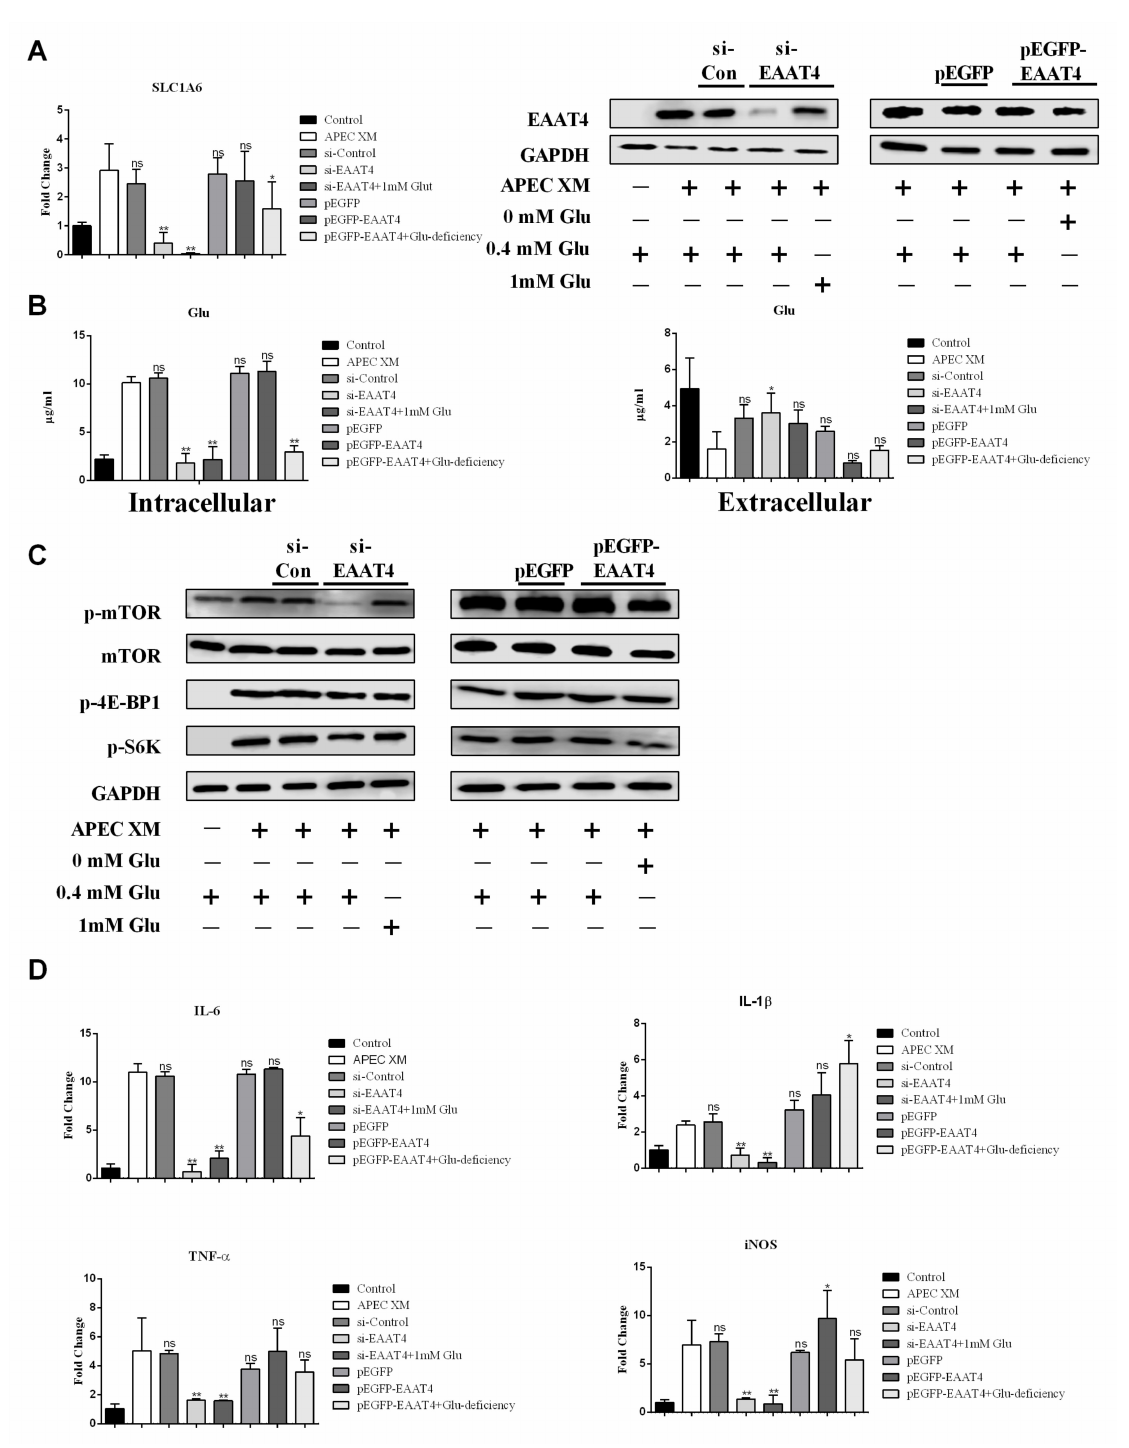
Figure 7. The effect of EAAT4 silencing and overexpression on Glu uptake, activation of the mTORC1 pathway, and inflammation. ( A ) The mRNA transcription and expression of Scl1a6 , respectively in EAAT4-silenced cells cultured in the complete or the 1 mM Glu supplement medium, or in EAAT4-overexpressed cells cultured in the complete, or the Glu deficiency medium, compared with APEC XM-infected cells. GAPDH and GAPDH were used as the reference control for RT-PCR and the blotting. Data are from one experiment representative of three independent experiments, with three to six replicates per group. Data represent means ± SD. ( B ) The intracellular and extracellular content of Glu, respectively